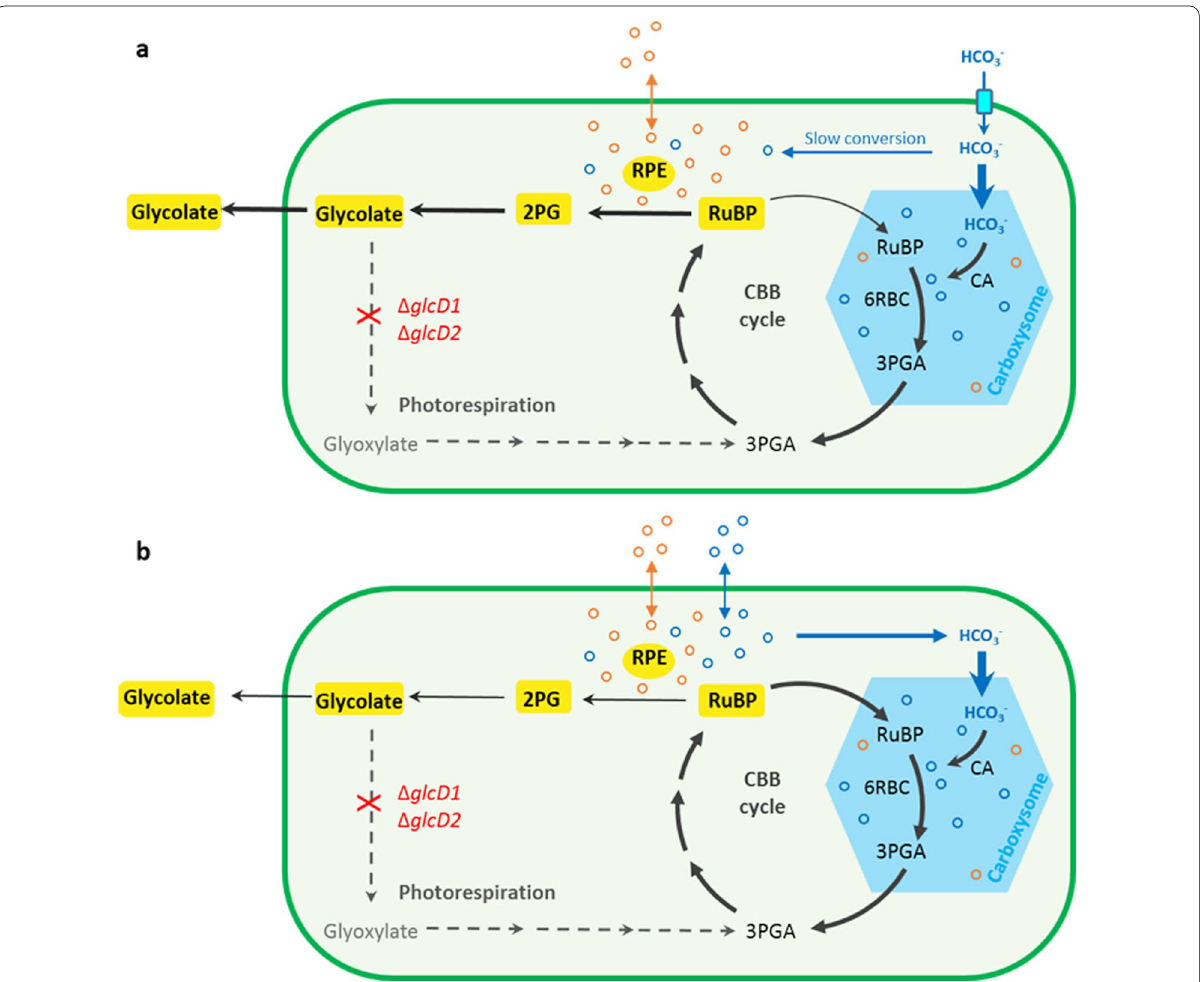
Fig. 6 The different impacts of HCO 3 − ( a ) and CO 2 ( b ) on glycolate production by RPE-ΔglcD. The orange cycles represent molecule oxygen and the blue cycles represent CO 2 . The diffusion of O 2 and CO 2 are indicated by orange and blue double headed-arrows, respectively. Bold solid dark arrows indicate the direction of the favored reaction under the growth